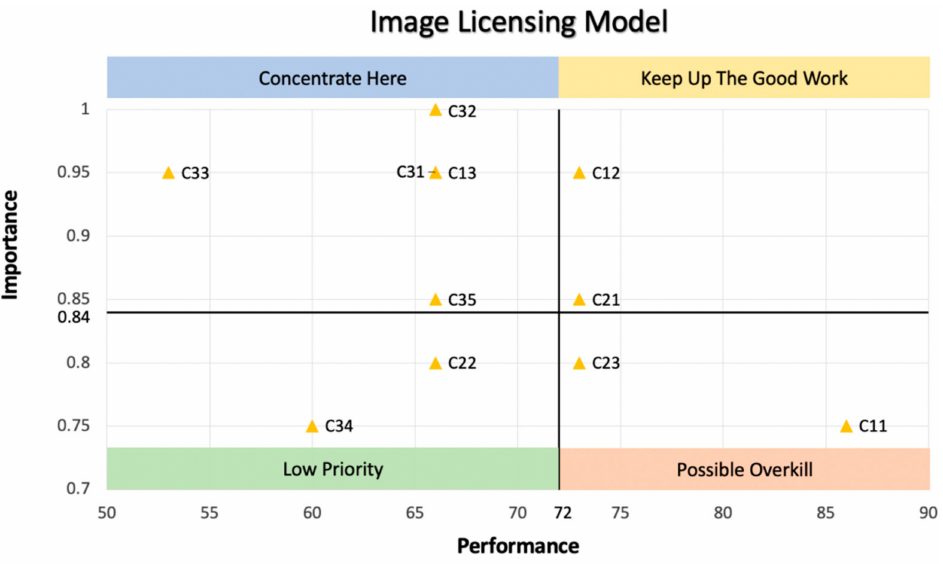
Figure 5. Importance–Performance Grid of Image licensing